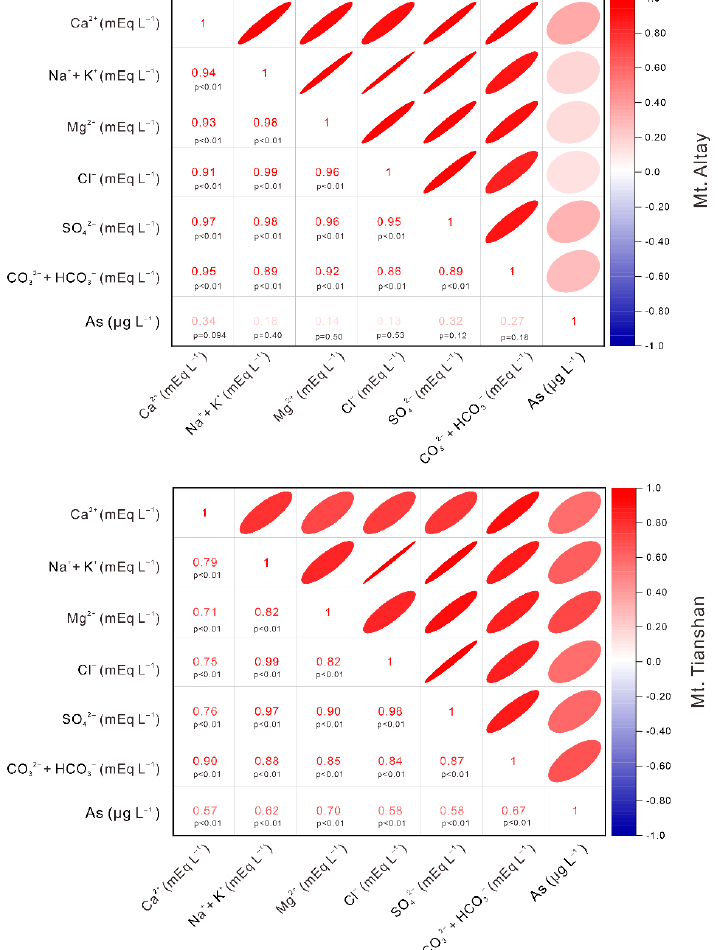
Figure 10. The correlation plots for the relationship among the major ions and arsenic (As) for waters in the regions of the Tianshan and Altay Mts. The flatness of the ellipse is consistent with the absolute value of the correlation coefficient. When the ellipse is close to the circle, the correlation coefficient is close to zero. The color of the ellipse corresponds to the sign of the correlation.